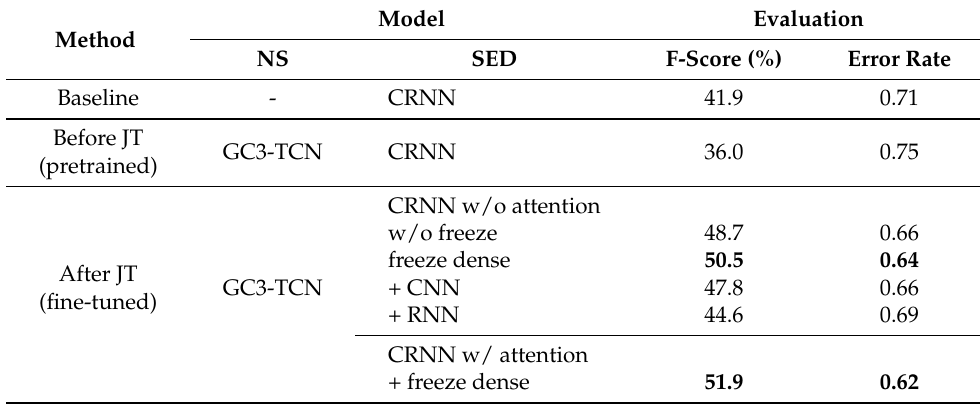
Table 4. Performance comparison using the real recorded noise dataset for input mixture. JT denotes joint